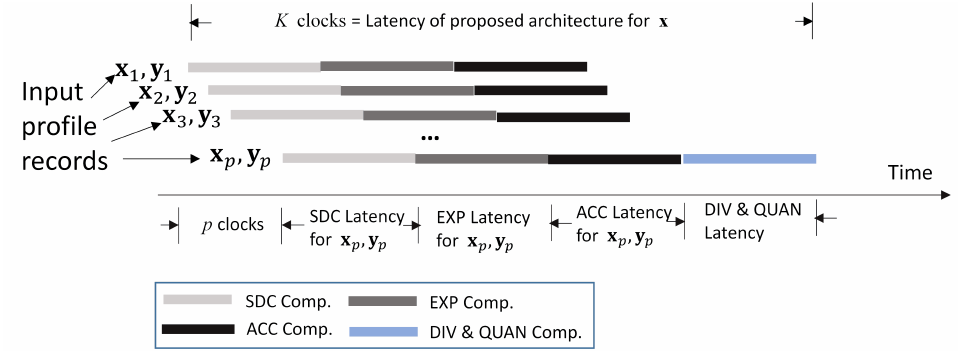
Figure 6. The pipeline operations for the GRNN prediction